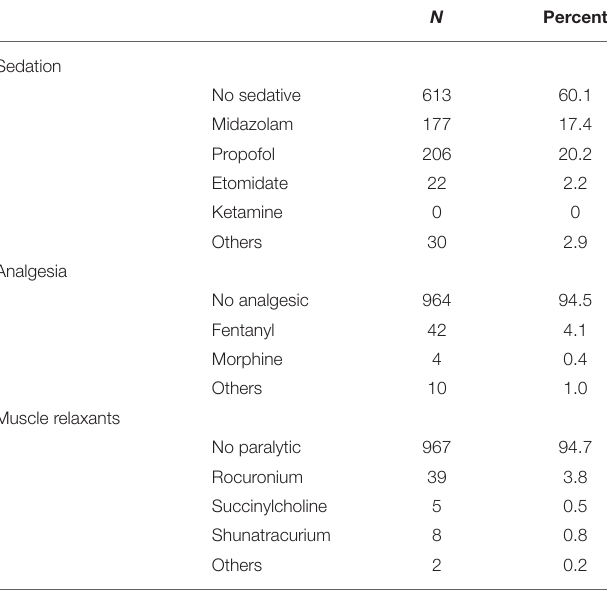
TABLE 3 | Induction agents used during ED